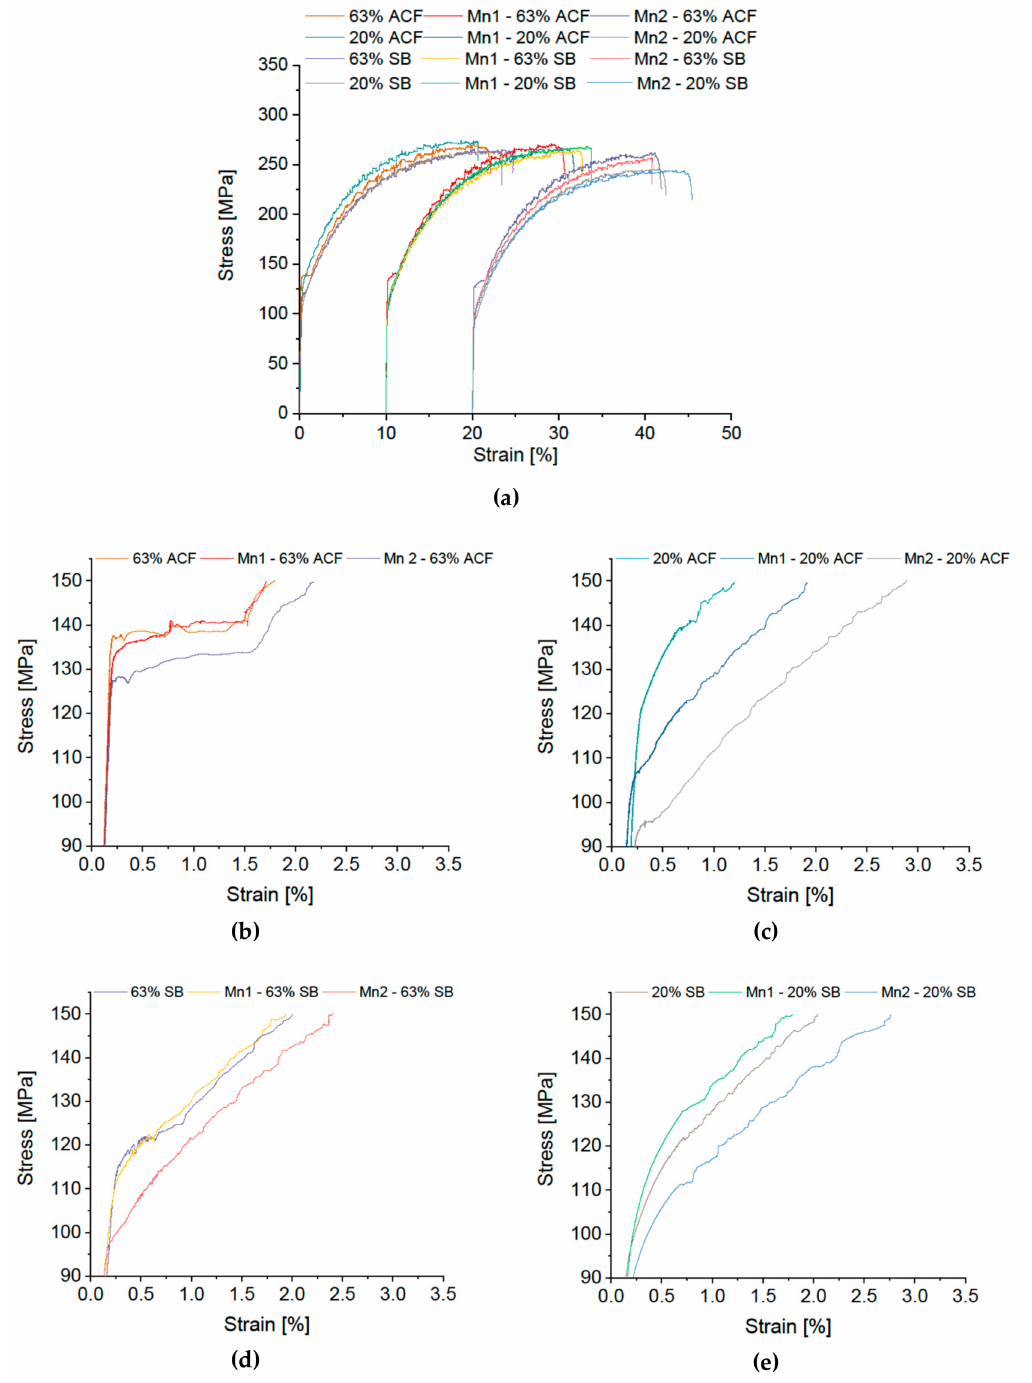
Figure 5. Stress-strain diagram of modified EN AW-5182 with di ff ering Mn content. ( a ) Overview; Details of Lüders elongation: soft annealing in ACF at 370 ◦ C with ( b ) 63% and ( c ) 20% cold rolling, salt-bath treatment at 500 ◦ C with subsequent water quenching with ( d ) 63% and ( e ) 20% cold rolling. The standard alloy with 0.41 wt % Mn is compared with 0.34 wt % and 0.20 wt % Mn variants. The σ - ε curves reveal pronounced Lüdering for 63% CR plus AFC for all Mn variations. For the alloys with higher Mn content a small kink in the σ - ε curves is visible for 63% CR plus SB, while the alloy with low Mn content exhibits a fairly smooth